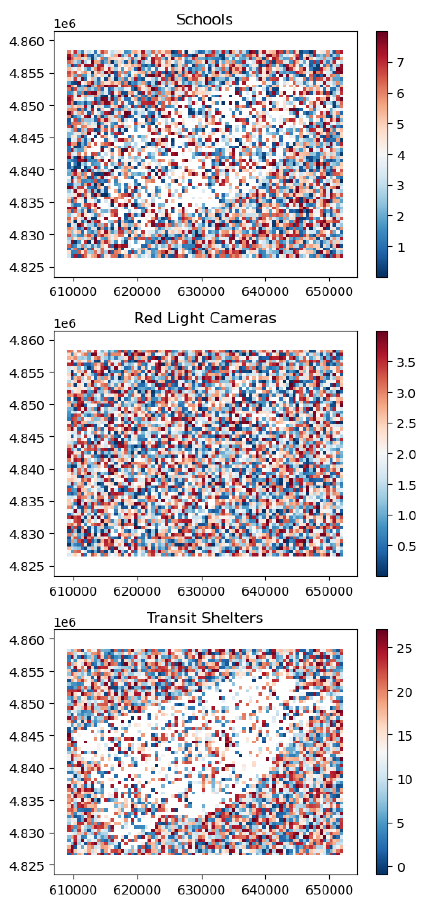
Figure 6 . Scenario 2 generated